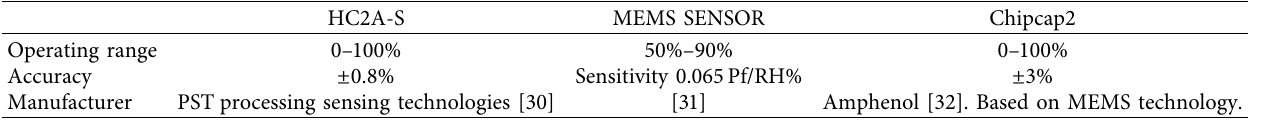
Table 1: Characteristics of some